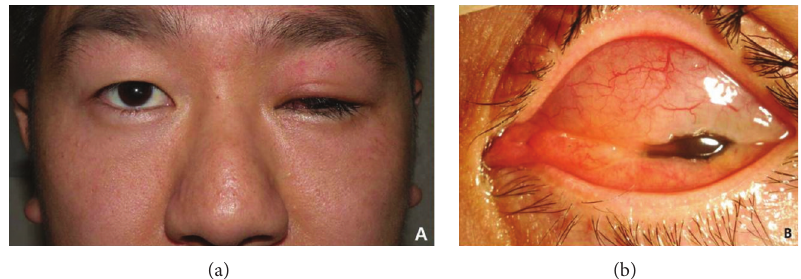
Figure 1: Clinical photographs at presentation. (a) Left upper eyelid shows diffuse erythematous swelling with complete ptosis. (b) Upper bulbar subconjunctival mass with underlying multiple small transparent lipid droplets of silicone oil.